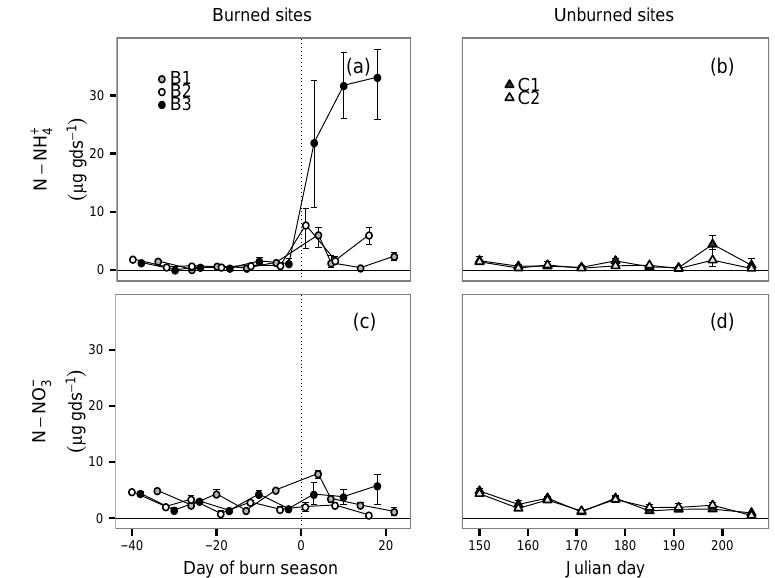
Figure 5. Changes in pool sizes of (a) NH + in control sites. in burned sites, (b) NH + in control sites, (c) NO − in burned sites, and (d) NO − 4 4 3 3 The x axis for A and C shows time (in days) centred on the date of burn; days immediately before the burn are negative x values, while days immediately following a burn are positive; the burn date is at 0 and is demarcated with a vertical dotted line. The x axis for sites B and D depicts time in Julian days. Prescribed burns in B1, B2, and B3 occurred on Julian days 185, 190, and 188, respectively. Pool sizes are reported in µgNgds − 1 . Error bars ( ± 95%CI) for individual time points may be obscured by the point.